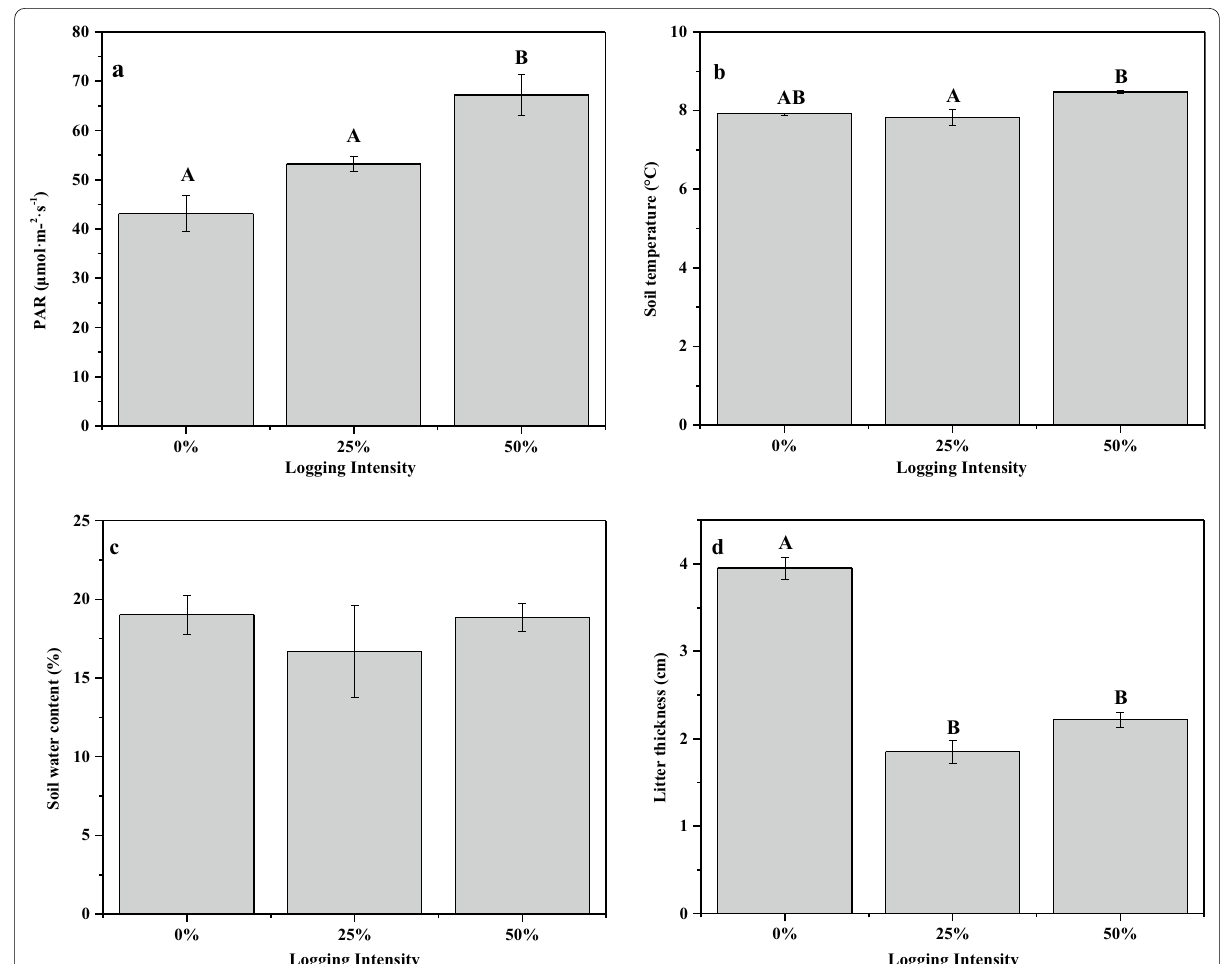
Fig. 2 Mean values of environmental parameters for the control (0%), 25% (25% of the basal area removal), and 50% (50% of the basal area removal) logging intensities from June 2018 to June 2019. The environmental factors include the photosynthetically active radiation (PAR) 1.0 m above the forest floor ( a ), soil temperature ( b ), soil water content ( c ) 5 cm below the ground, and litter thickness in August ( d ). Different capital letters above the column indicate a significant difference at P < 0.05 among three logging intensities. The values are presented as means